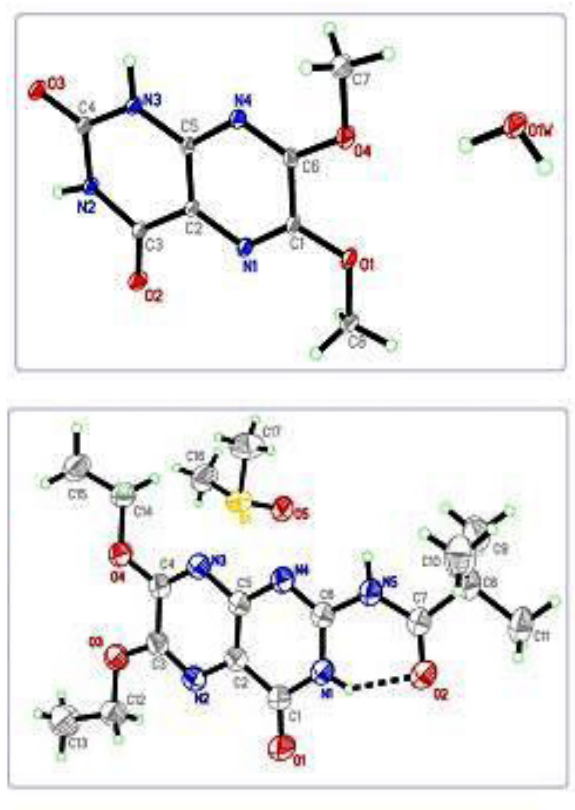
Figure 16: Crystal structures of compounds 12 and 17 (adapted from